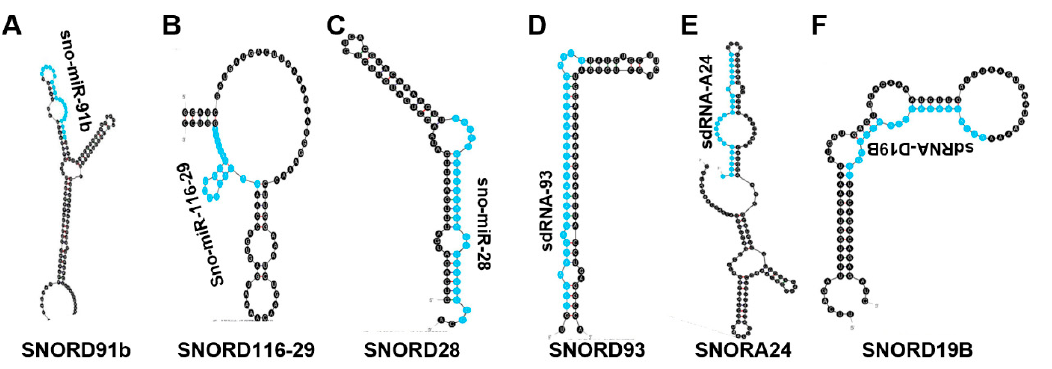
Figure 5. sdRNAs not Previously Annotated as miRNAs. ( A – F ) The most thermodynamically stable secondary structures of sdRNA producing snoRNA transcripts were generated by mfold [20]. Highlighted in blue are sdRNAs shown to function as bona fide miRNAs. ( A ) sdRNA produced by SNORD91B (ENSG00000275084) was determined to be downregulated in PDAC [70]. ( B ) sdRNA which arises from SNORD116-29 (ENSG00000207245) was determined to be downregulated in PDAC [70]. ( C ) sdRNA derived from SNORD28 (ENSG00000274544) was found to function as a tumor-promoting RNA and is upregulated in breast cancer []. ( D ) sdRNA excised from SNORD93 (ENSG00000221740) was found to function as a tumor-promoting RNA and is upregulated in breast cancer [72].( E ) sdRNA produced from SNORA24 (ENSG00000275994) was functionally identified as a tumor-promoting RNA and is upregulated in prostate cancer [73]. ( F ) sdRNA derived from SNORD19B (ENSG00000238862) was determined to function as a tumor-promoting RNA and is upregulated in prostate cancer [73].